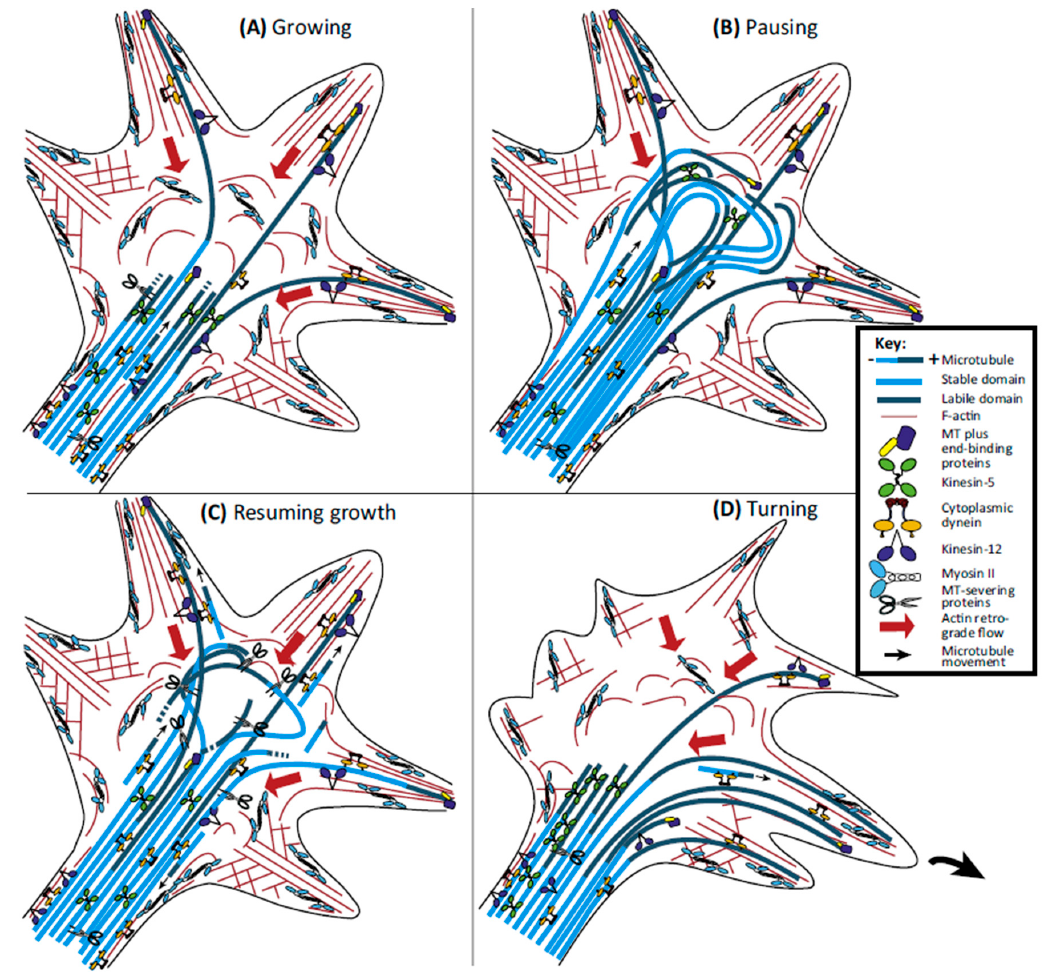
Figure 12. Behavior of microtubules during the different phases of the activity of the growth cone. ( A ) During the advance of the growth cone, dynein generates traction forces that allow microtubules to overcome retrograde flow and to invade the peripheral domain and filopodia. The cut-out of the labile portion of the microtubules (dark blue) regulates the length of that portion, while cutting the stable portion of microtubules (light blue) creates short and more motile ones. ( B ) When the growth cone pauses, the progress of microtubules results in a non-compartmentalized growth cone in central and peripheral domains, which is dominated by a bundle of curved microtubules. ( C ) When the axon restarts the growth, microtubules disperse rapidly and increase their cutting rate, causing shorter microtubules to be thrown away from the beam. ( D ) When the growth cone needs to turn, the forces generated by the motor proteins kinesin-5 and kinesin-12 become polarized towards the opposite side to the direction of rotation; in this way, the forces driven by dynein allow the invasion of microtubules only on the side of the growth cone that is going to turn. The small black arrows indicate the direction of the movement of short microtubules. The long red arrows indicate the retrograde flow of actin. Reprinted from: [225] , with the permission of Elsevier. As presented before, the cytoskeleton, as well as its dynamics, is essential for the development and the function of the nervous system but is also particularly important for its maintenance during adulthood. In addition to this, there is a shred of increasing evidence that shows how defects of the